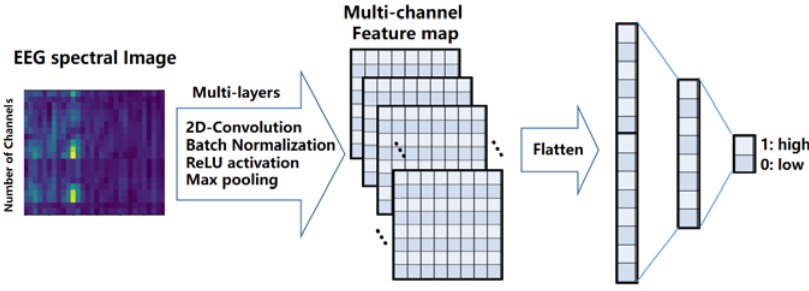
Fig. 4. Structure of the 2D-CNN model based on EEG spectrogram